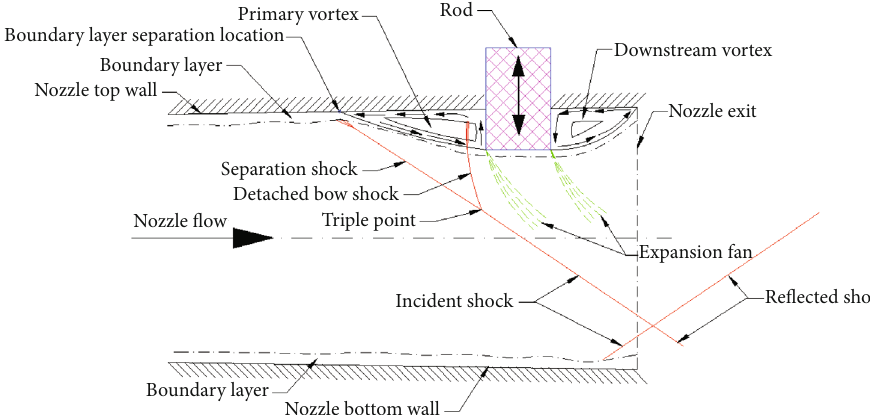
Figure 2: Schematic of fl ow features around the rod in a supersonic